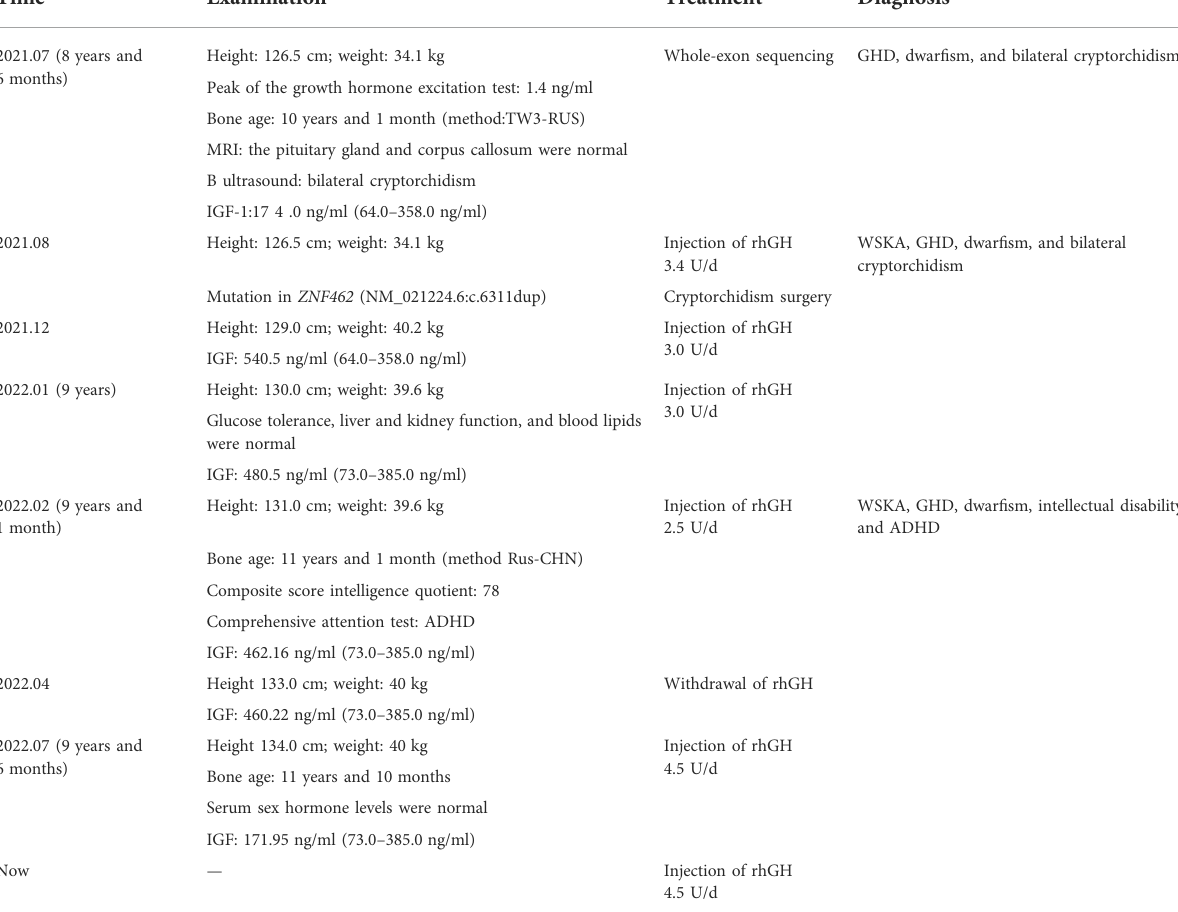
TABLE 1 Timeline with relevant data from the episode of care.